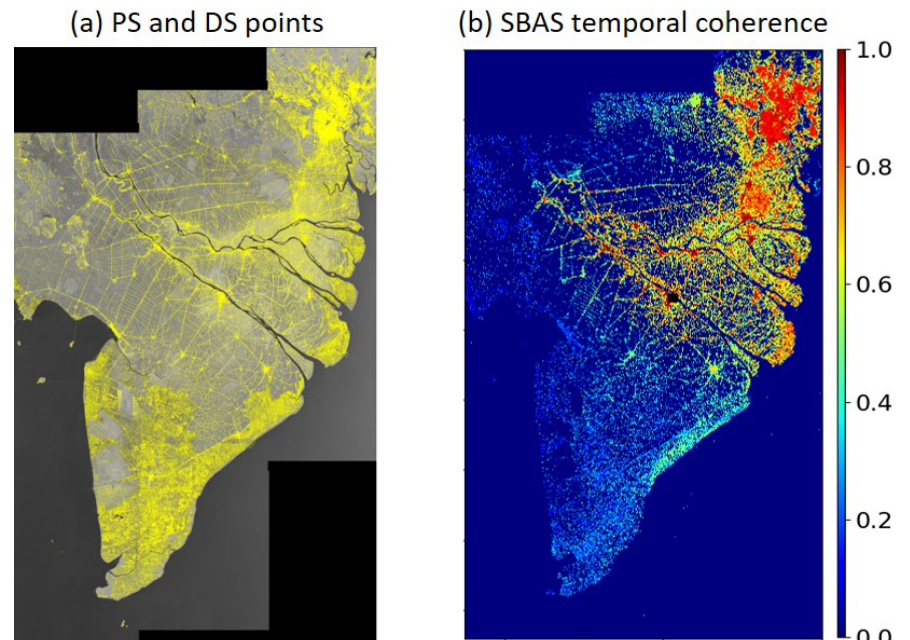
Figure 3. PSDS and SBAS methods for Mekong Delta-wide coveraged about 300 km × 250 km. ( a ) The yellow color denotes the position of 14 × 10 6 PS and DS candidates. ( b ) The temporal coherence of 38 × 10 6 pixels from the SBAS